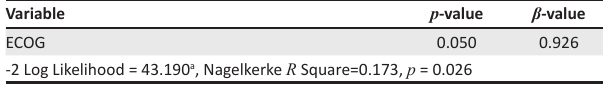
TABLE 5: Factors associated with postoperative complications.